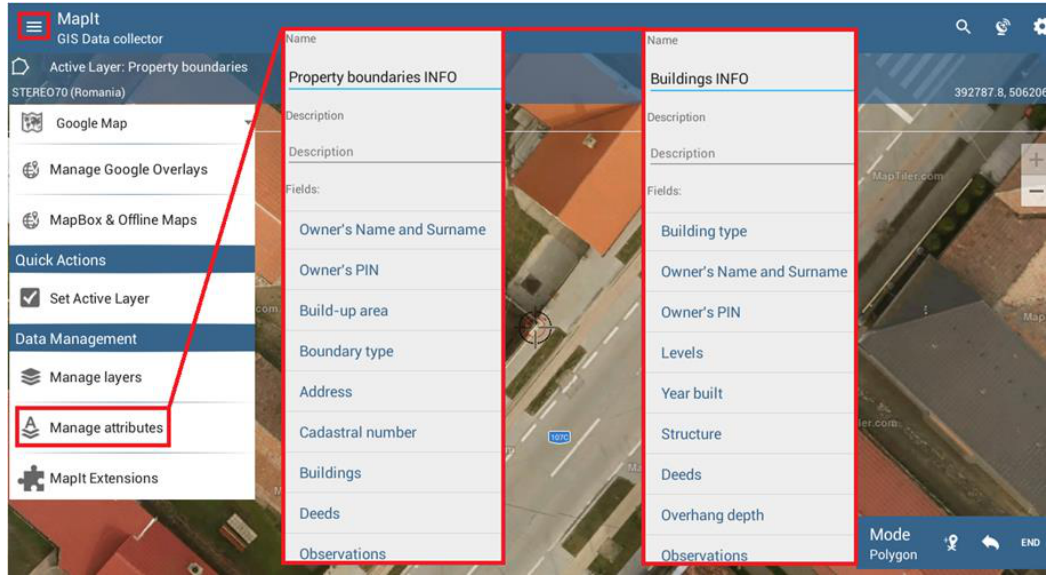
Figure 10. Managing attributes in MapIT application.